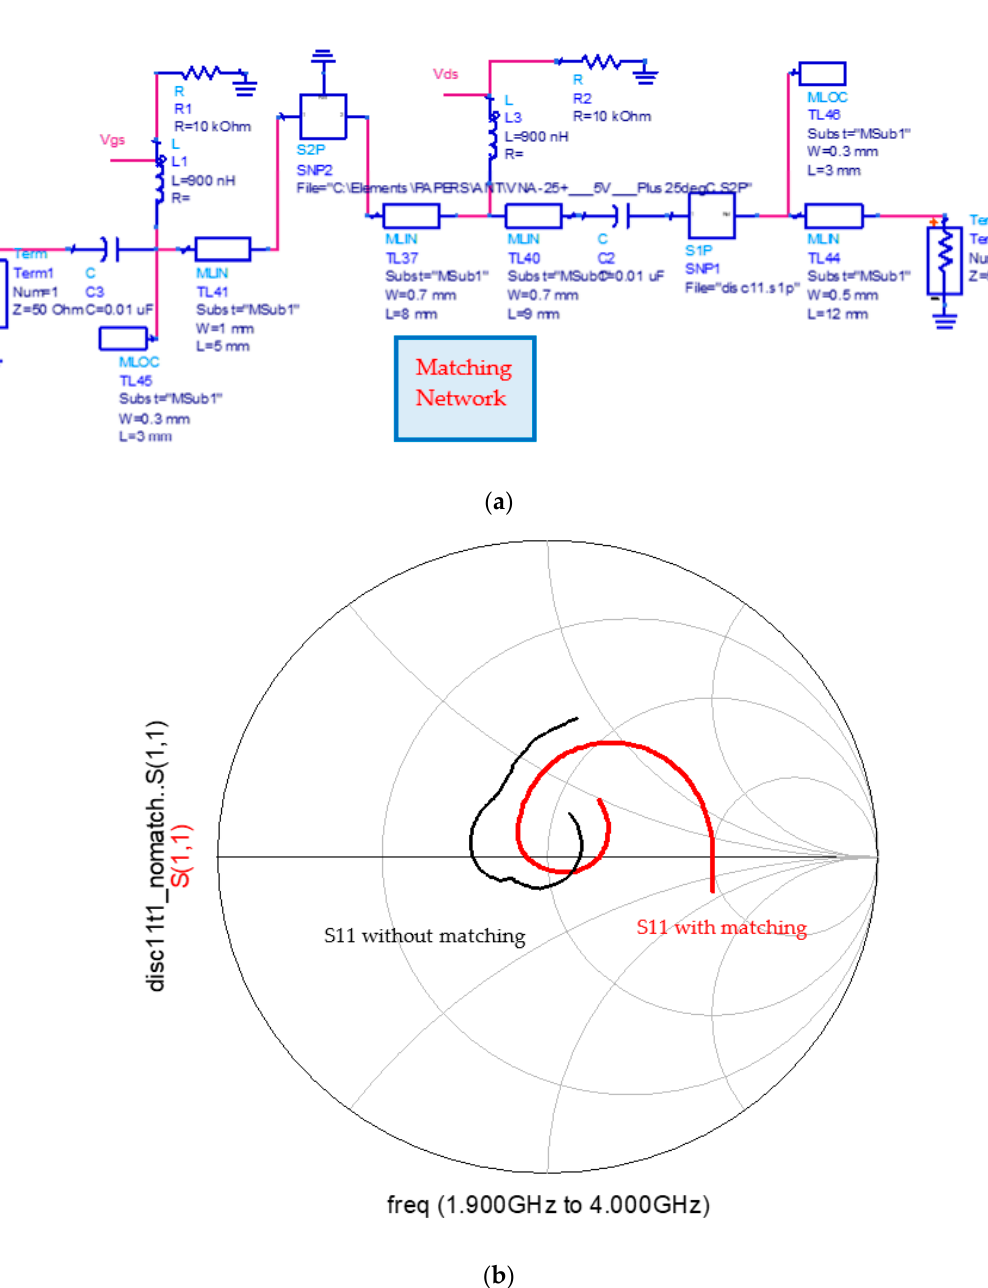
Figure 13. Transmitting Circular Patch antenna: ( a ) Matching network; ( b ) S11 of the active antenna.